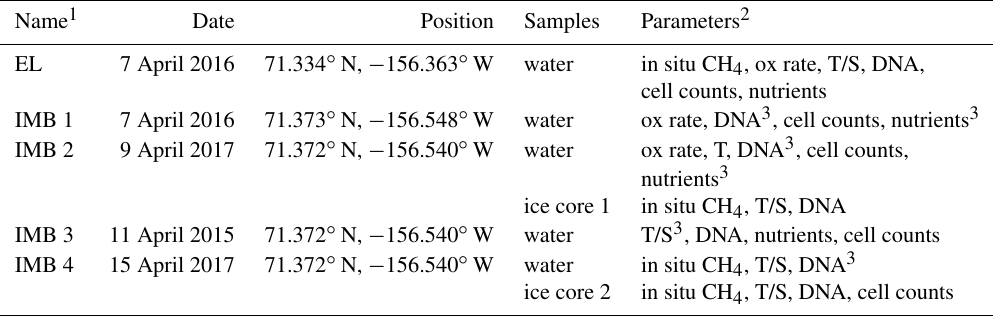
Table 1. Station and sample